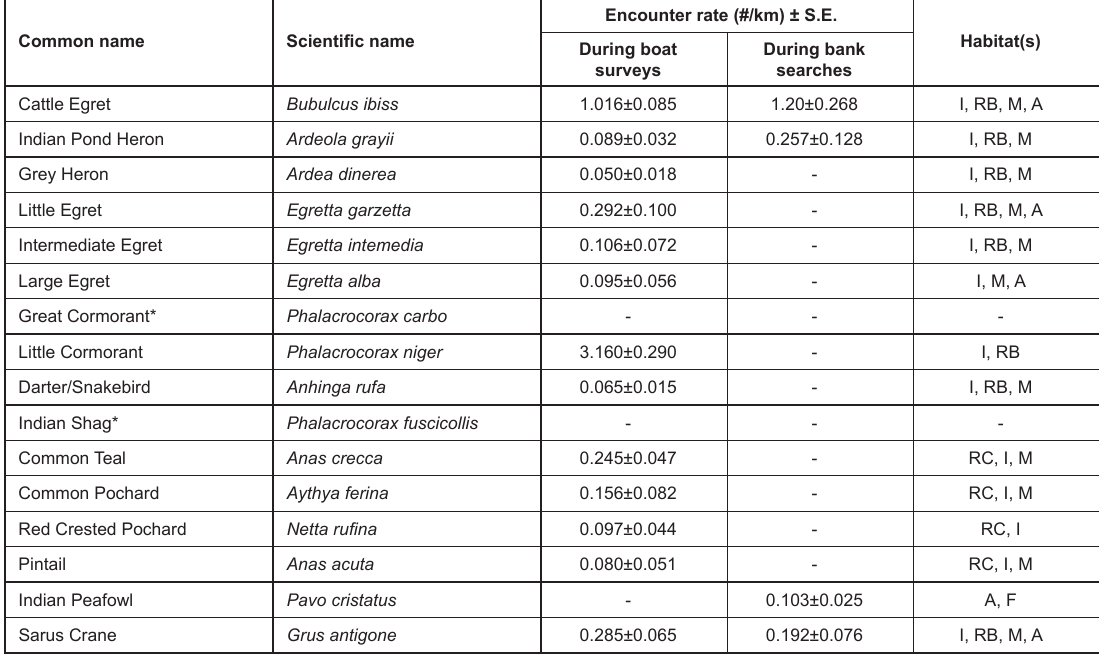
Table 2. List of avian species recorded along upper Ganges and its